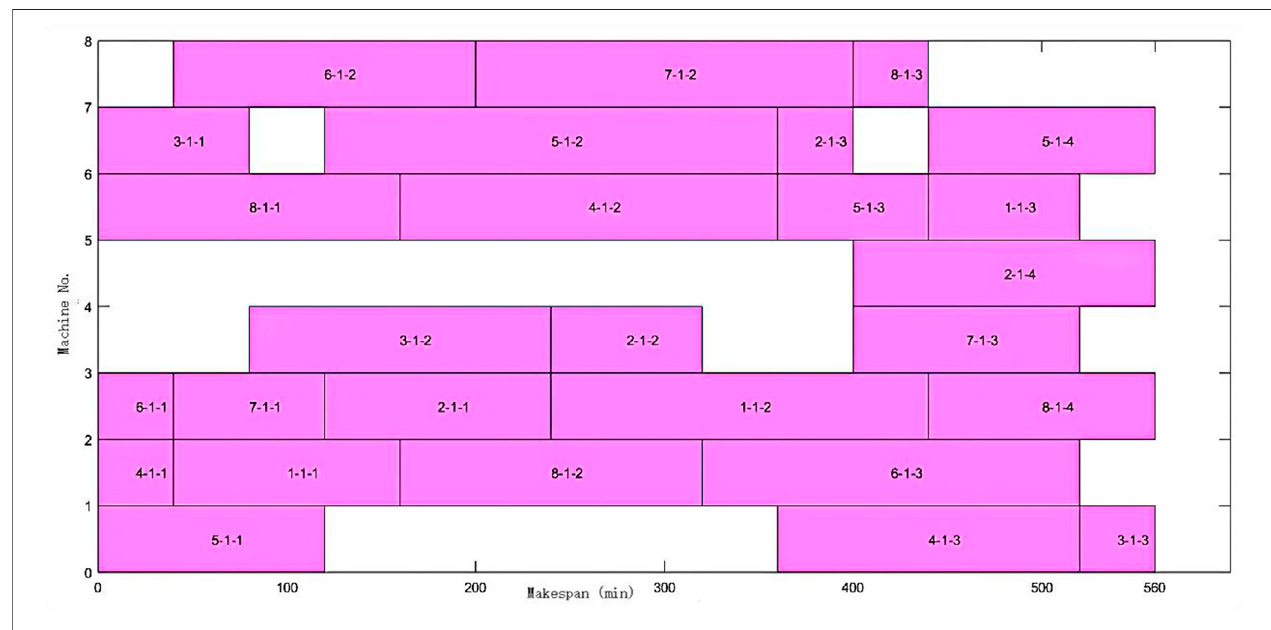
FIGURE 7 | Kacem 8 × 8 Gantt chart without batch splitting.